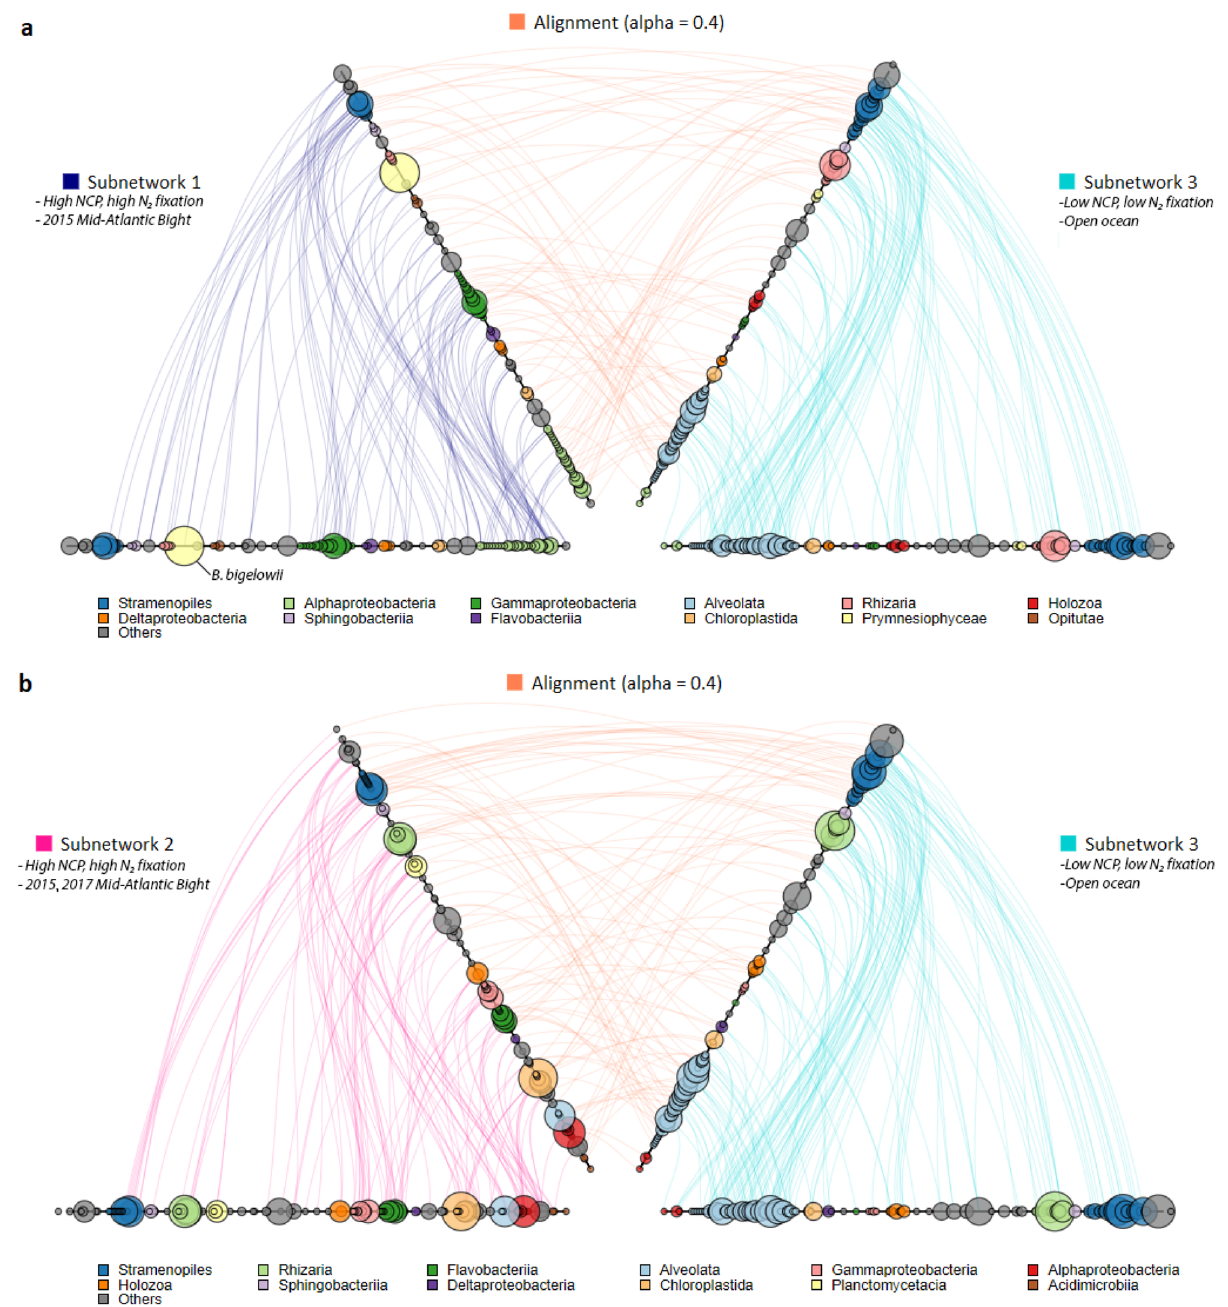
Figure 7. Alignment plots from co-occurrence and graph alignment analyses illustrate differences in ecological patterns and relationships between low N 2 fixation + Low NCP and high N 2 fixation + high NCP subnetworks. ( a) Visualization of network relationships within and contrasted between Subnetwork 1 (2015 MAB, high N 2 fixation) and Subnetwork 3 (open ocean, low N 2 fixation) ( b) and Subnetwork 2 (2015 + 2017 MAB, high N 2 fixation) and Subnetwork 3 (open ocean, low N 2 fixation). The leftmost pair of identical axes represent taxa belonging to the first subnetwork, with edges between the left two axes signifying significant co-occurrence relationships between taxa within the subnetwork. The rightmost axes and lines similarly represent taxa from the second subnetwork and within-network co-occurrence relationships. Edges between the two networks represent aligned taxa, where an OTU shares a similar taxonomic identity (sequence similarity) and a high degree of network topological similarity with an OTU in the other subnetwork. Alignments suggest that OTUs fill similar ecological roles within their respective subnetworks. Circular nodes represent individual OTUs, colored and grouped at the third taxonomic rank. Larger circle diameter indicates higher network importance (centrality). Taxa are ordered by centered log-ratio (CLR) normalized abundance, with higher-abundance genera placed further from the origin. Figure produced using HiveAlign (https ://univ-nante s.io/erwan .delag e/ HiveA